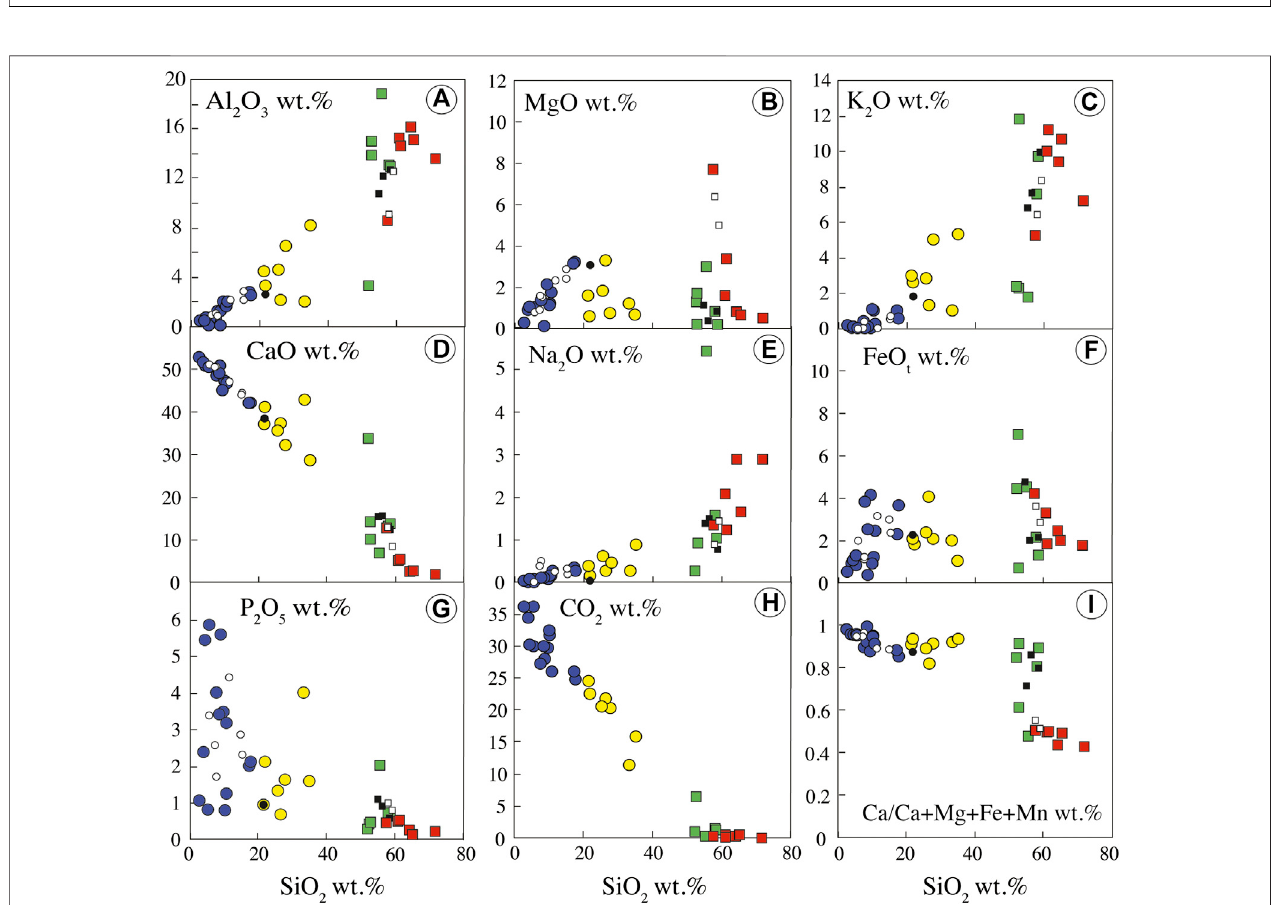
FIGURE 5 | Bulk rock major oxide compositions of the Ihouhaouene carbonatites and syenites. Symbols as in Figure 4 .